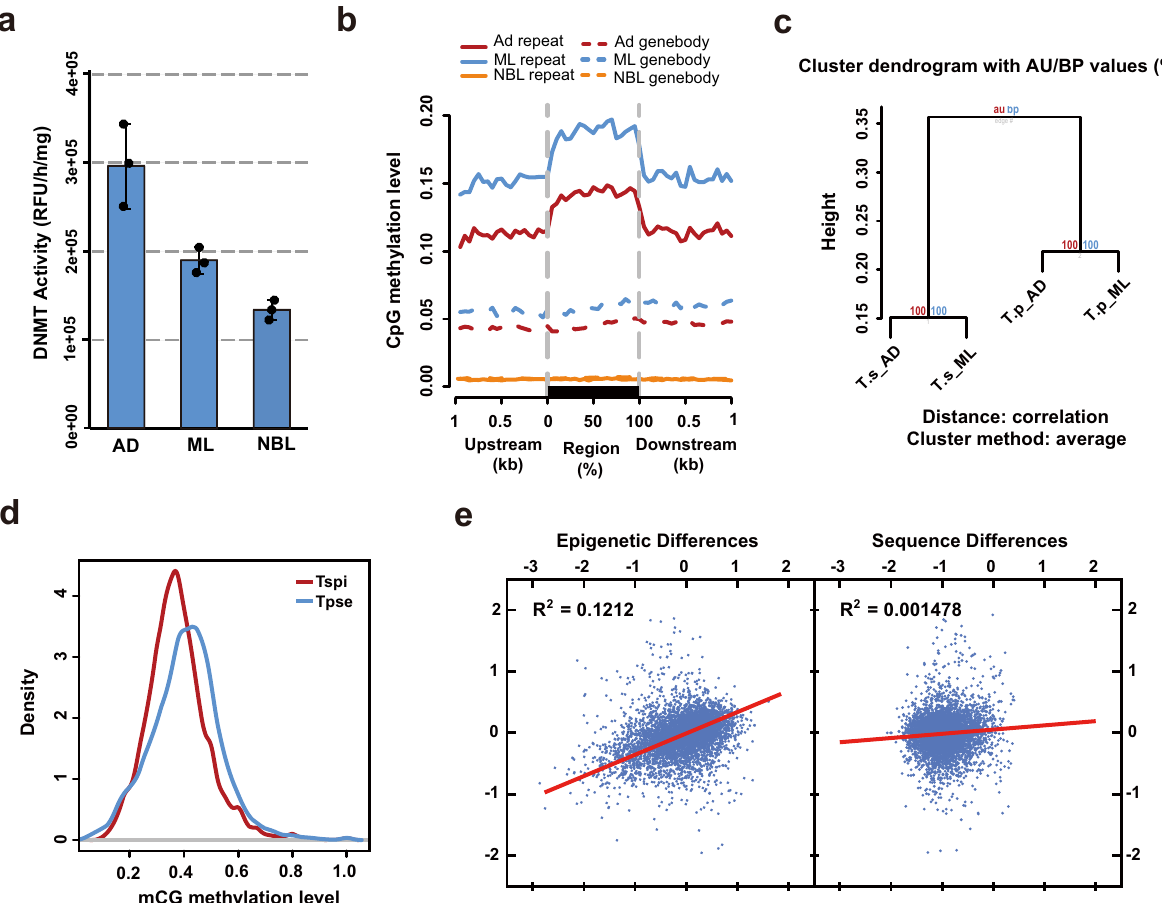
Fig. 1 Con fi rmation and characterization of T. pseudospiralis methylome in comparison with T. spiralis . a Results of catalytic activity of T. pseudospiralis DNMTs. Triplicates of DNMT activity experiments were carried out and mean ± SD is indicated. DNMT activity (OD/h/mg) = (Sample OD − Blank OD)/ (Protein amount ( μ g)× hour) ( N = 3 biologically independent experiments for each DNMT). b CpG methylation levels of repeat and gene body regions. Two-kilobase region upstream and downstream of each gene was divided into 100-bp (bp) intervals. Each repeat or gene body region was divided into 20 intervals (5% per interval). c Clustering of methylation levels of common CpG sites in the whole-genome of all the four samples was used in the “ Pvclust ” algorithm. d Comparison of mCG methylation level density between T. pseudospiralis and T. spiralis . e Correlations among evolutionary changes of epi- modi fi cation intensities, gene expression levels, and genomic sequences.